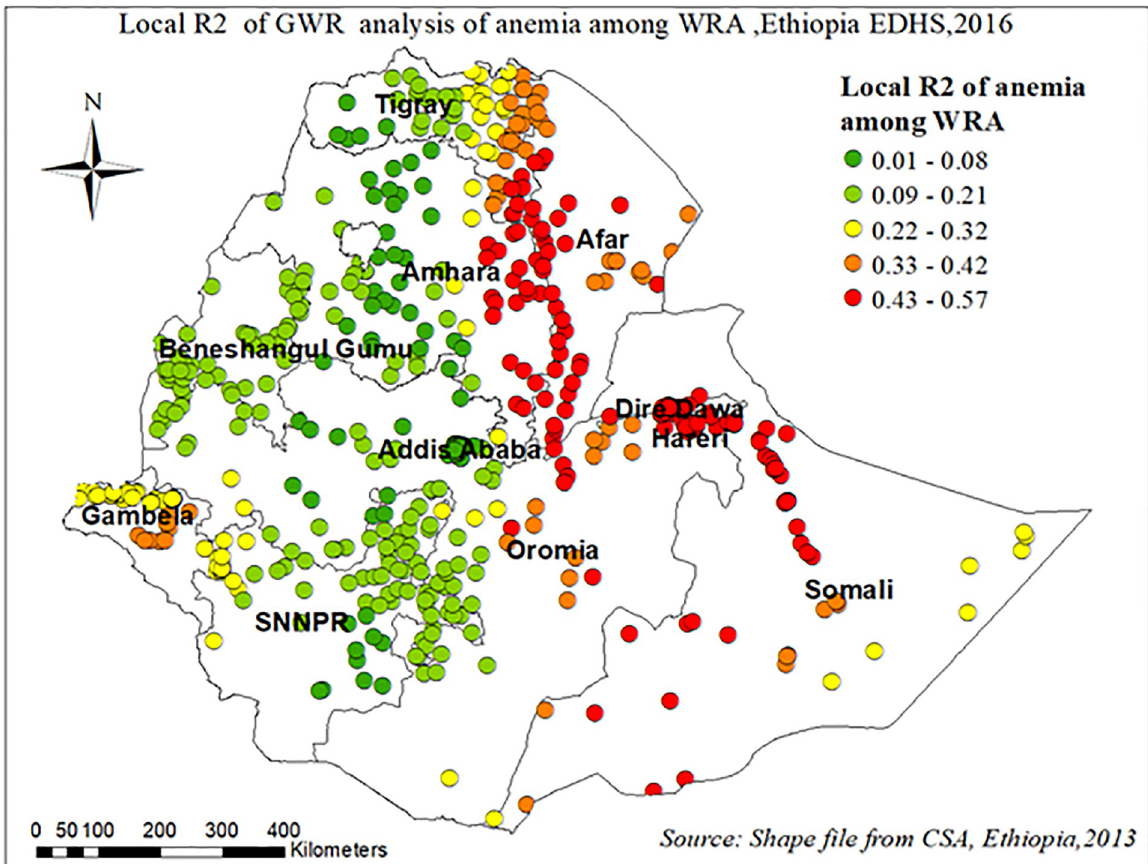
Fig 10. Local R2 of GWR analysis anemia among reproductive age women in Ethiopia, EDHS 2016.